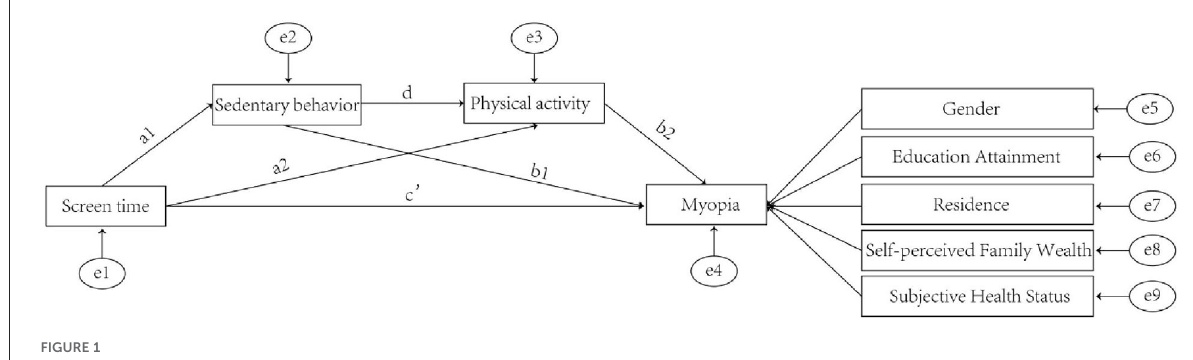
FIGURE1 SEM diagram.